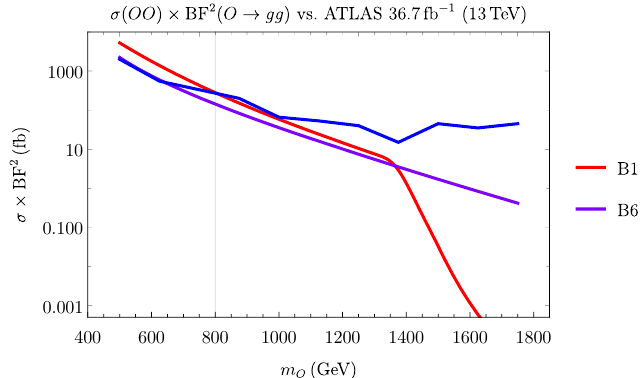
Figure 12. Cross sections in benchmarks B1 and B6 of scalar sgluon pair production with sub- sequent decays to gluons compared to exclusion bound from ATLAS 36.7 fb (cid:0) 1 (13 TeV) search for color-octet scalars assuming BF( O ! gg ) = 1. Exclusion is denoted by blue line. Gray line marks ATLAS lower limit m O (cid:21) 800